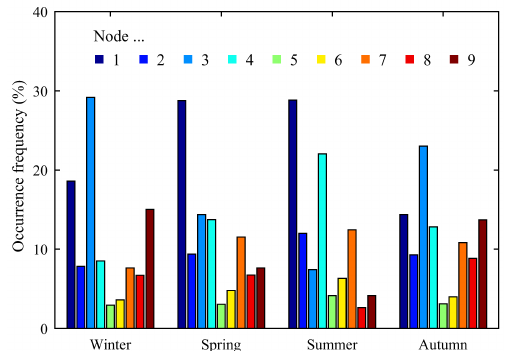
Figure 2. Relative frequency of individual ABL types (i.e., SOM nodes) in all four seasons: winter (DJF), spring (MAM), summer (JJA) and autumn